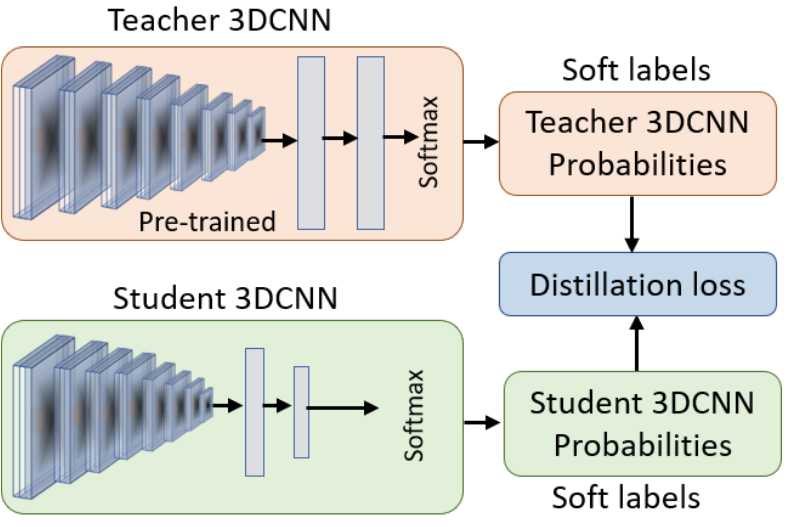
Figure 3. The visual overview of the proposed offline knowledge distillation approach, transferring knowledge from the pre-trained teacher to the student